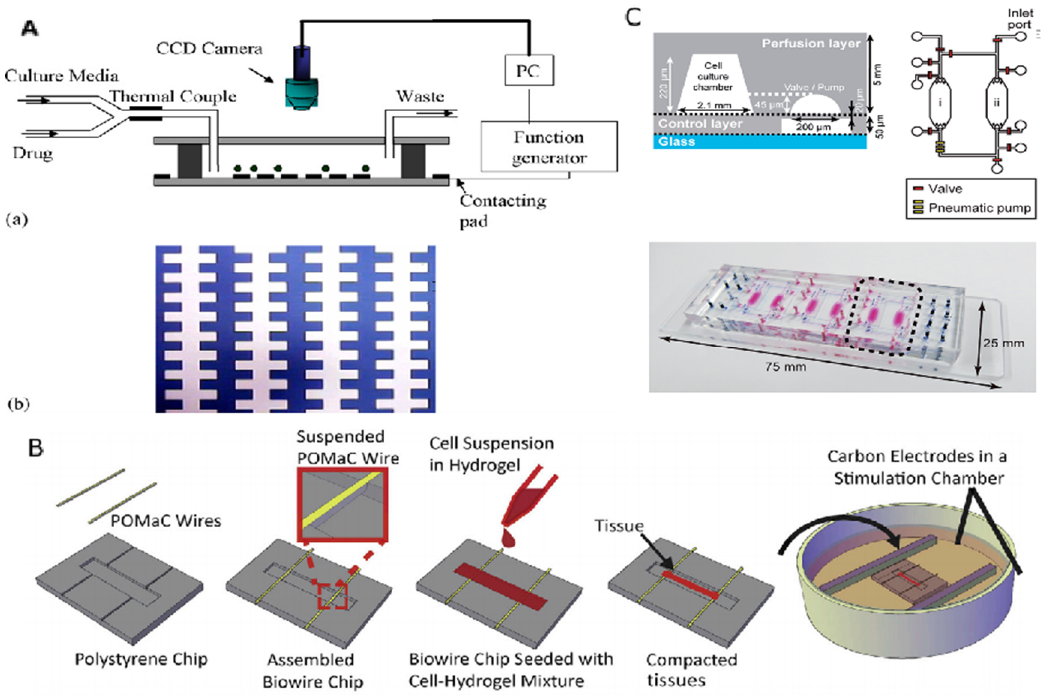
Figure 3. A heart chip system for drug toxicity testing. ( A ) Schematic of the first microfluidic devices to CMs anisotropy [91]. ( B ) Representative tissues in the Biowire II platform [96]. ( C ) Design of the microfluidic device used for integrated heart/cancer-on-a-chip (iHCC) [98].